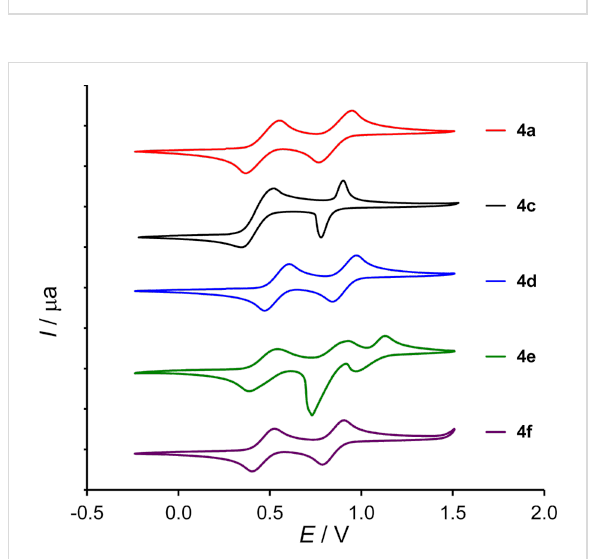
Figure 4: Cyclic voltammograms of compounds 4a,c [22] and 4d–f (plotted vs SCE; CH 2 Cl 2 /0.1 M Bu 4 NClO 4 ).